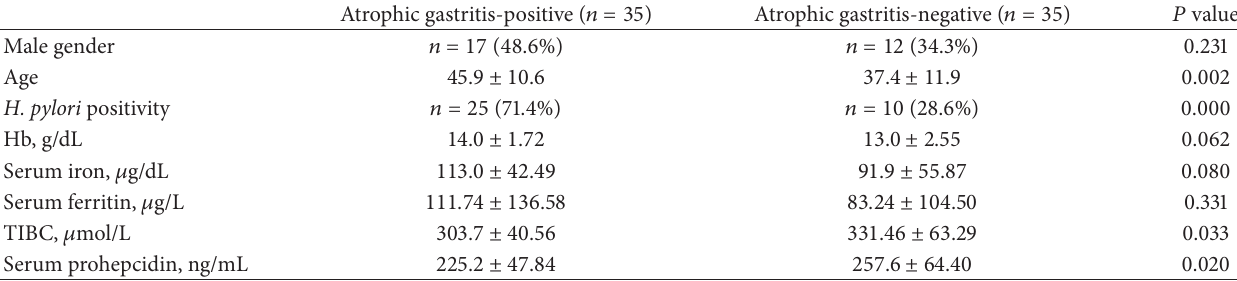
Table 1: Demographic feature, hematological and biochemical parameters in the study groups. Atrophic gastritis-positive ( 𝑛 = 35 )